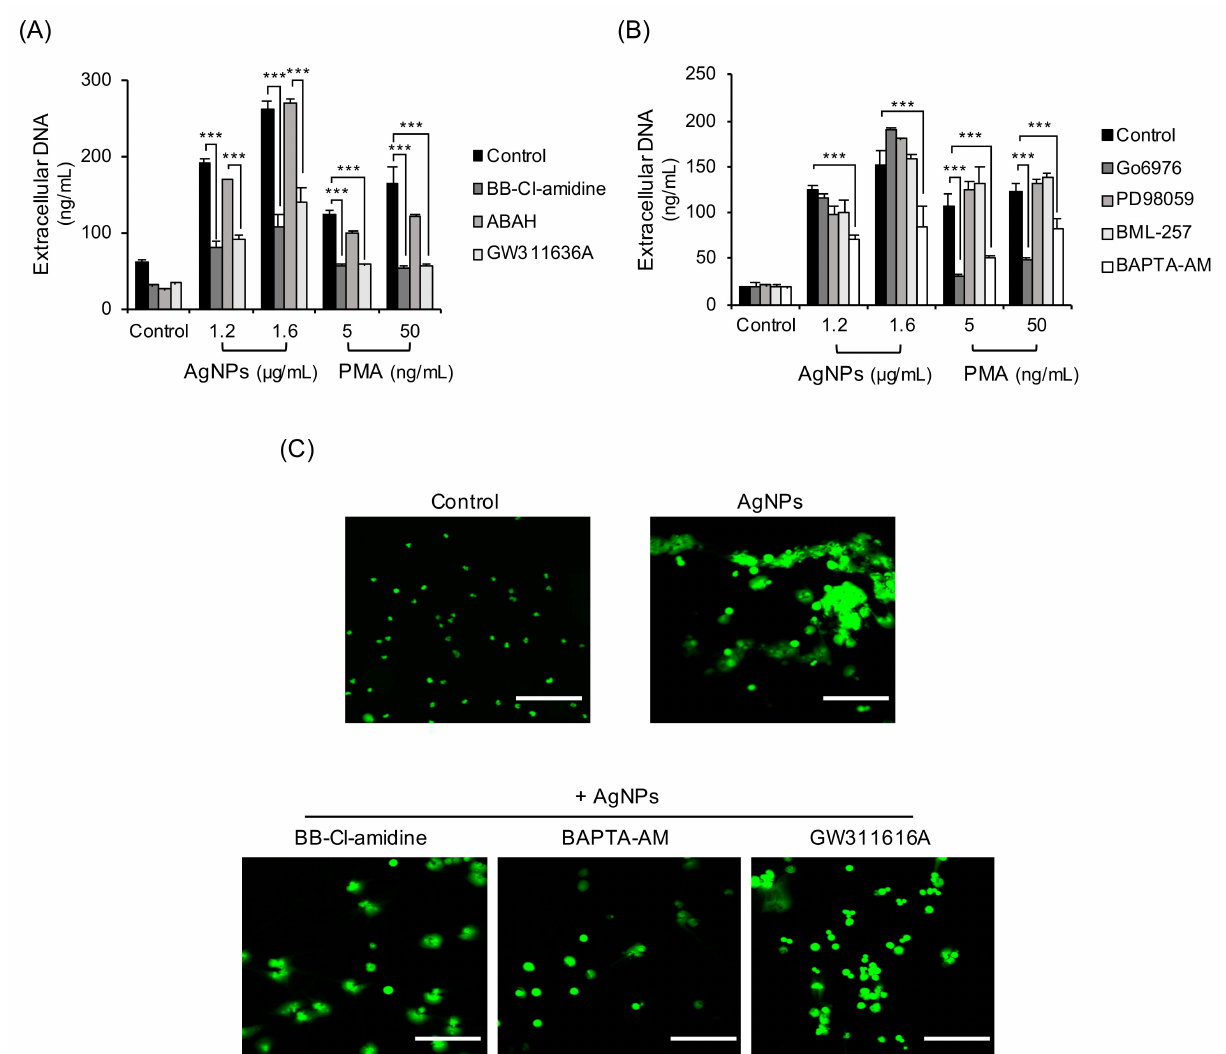
Figure 6. Mechanisms of NET formation by 5 nm AgNPs. Human neutrophils were pretreated with inhibitors that included ( A ) BB-Cl-amidine (8.8 µ M, 20 min) (PAD inhibitor), ABAH (500 µ M, 30 min) (MPO inhibitor), GW311616A (20 µ M, 30 min) (neutrophil elastase inhibitor), ( B ) Go6976 (1 µ M, 30 min) (PKC inhibitor), PD-98059 (40 µ M, 20 min) (MEK-1 inhibitor), BML-257 (20 µ M, 20 min) (Akt inhibitor), and BAPTA-AM (10 µ M, 15 min) (intracellular calcium chelator). This was followed by 4 h exposure to 5 nm AgNPs or PMA. Extracellular DNA was measured by a fluorescence plate reader. ( C ) Human neutrophils were pretreated with the inhibitors BB-Cl-amidine, BAPTA-AM, and GW311616A and treated with 1.6 µ g/mL 5 nm AgNPs for 4 h. The cells were fixed with 5% paraformaldehyde and stained with SYTOX Green for DNA staining. Scale bar: 100 µ m. Two-way ANOVA was used to determine the significance (*** p < 0.001). All experiments were performed in duplicate and repeated three times with different